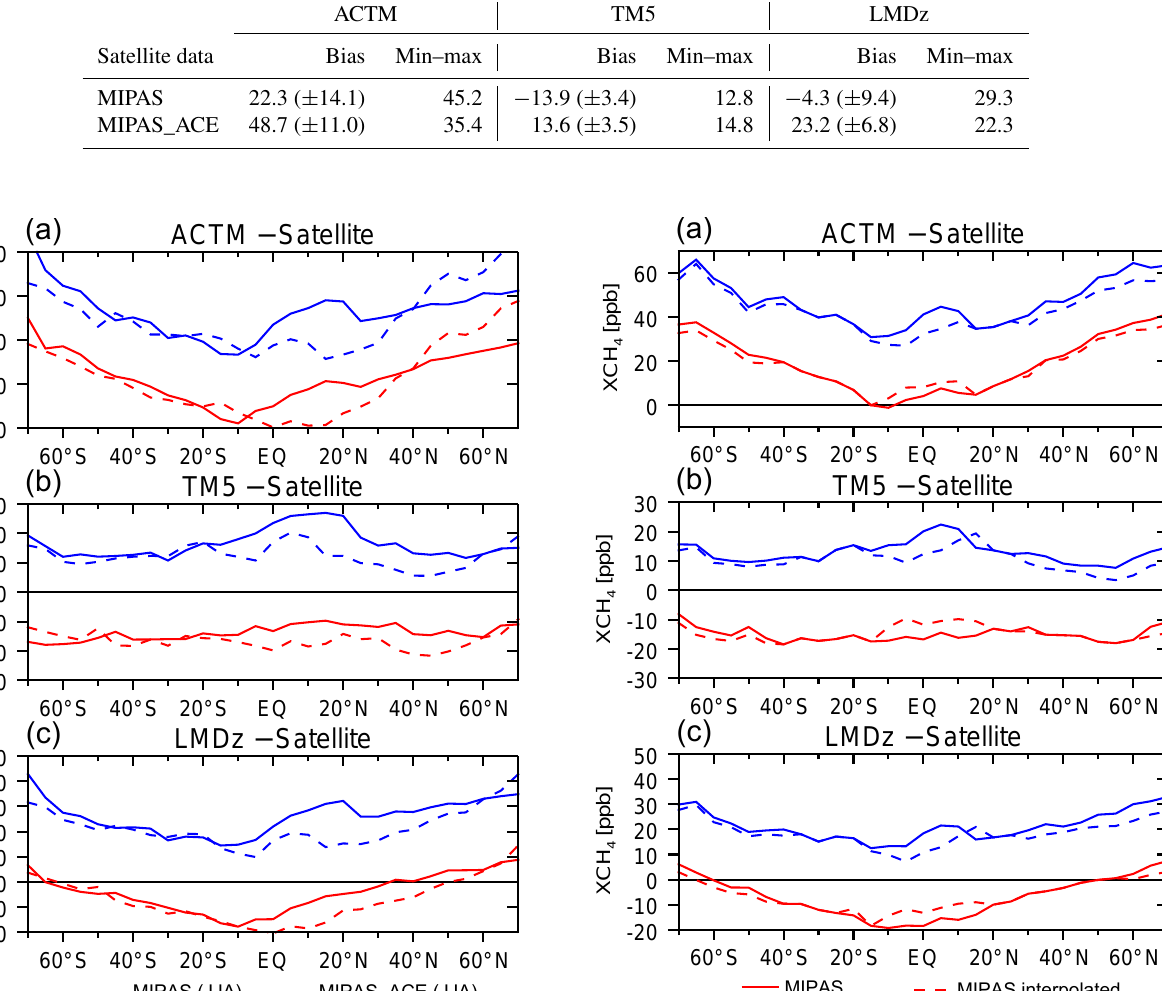
to each latitudinal MIPAS grid point corresponding to a ver- tical profile of CH 4 mixing ratios. The method was not used if the model–satellite difference of CH 4 mixing ratios was smaller than 30 ppb at the lower boundary of the transition range. Consequently, we also computed XCH 4 differences between the original model and the smoothed satellite-based data sets. Figure 6 then shows model–satellite XCH 4 differ- ences resulting from the force replacement (solid lines) and from the smoothly interpolated replacement (dashed